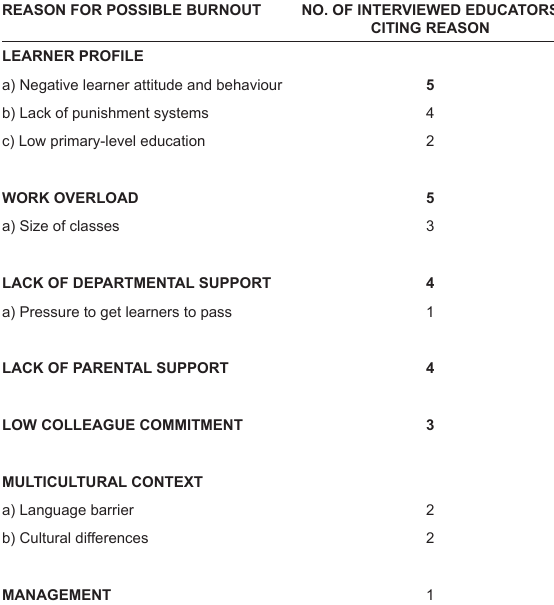
TABLE 5 Probable reasons for burnout from the interview